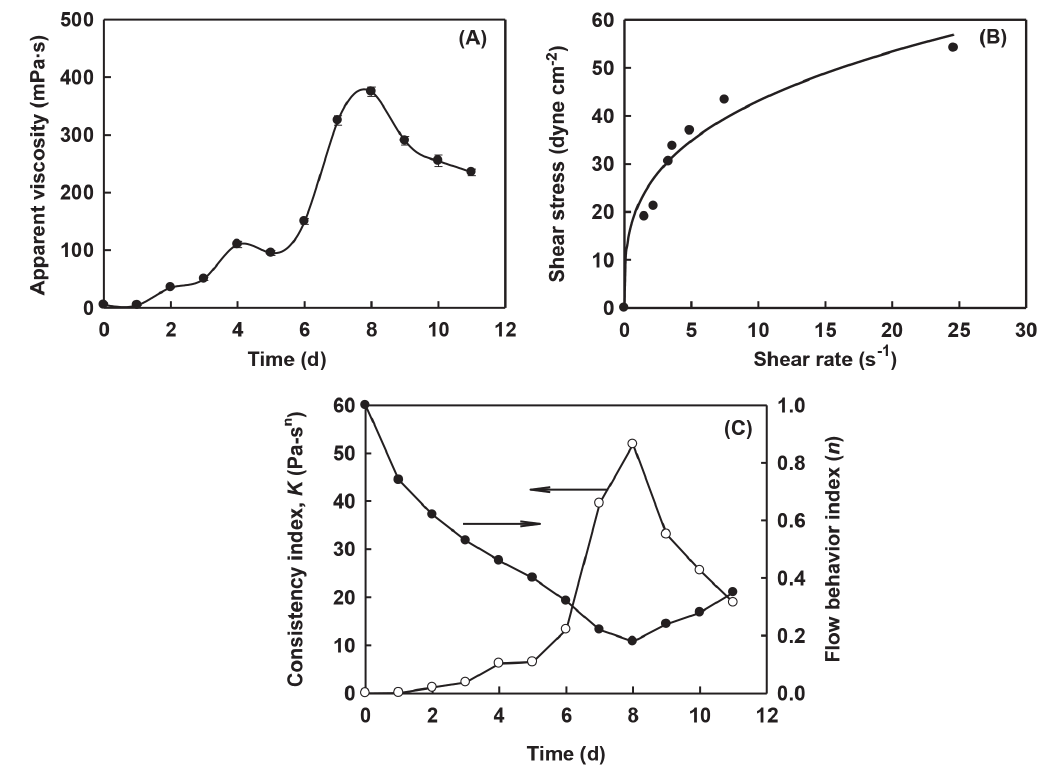
Fig. 2 - Rheological properties of P. geesteranus 5 # mycelial broth over the fermentation period: apparent viscosity of whole fermentation broth (A) ; rheographs for fermentation broth (shear stress vs. shear rate plots) (B) , and the variation in consistency index (K) and flow behavior index (n) of whole fermentation broth (C) .